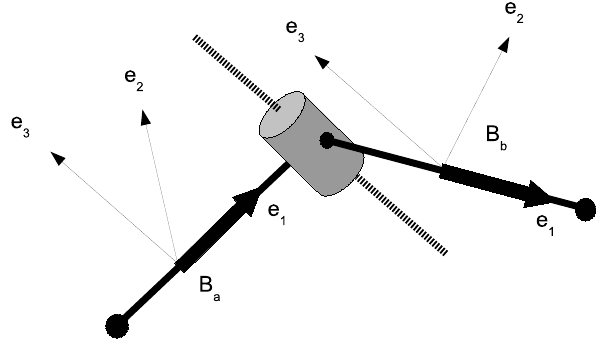
Figure 4. The revolute joint and the choice of the local coordinates. The axis of rotation is parallel to e 3 of the body B b